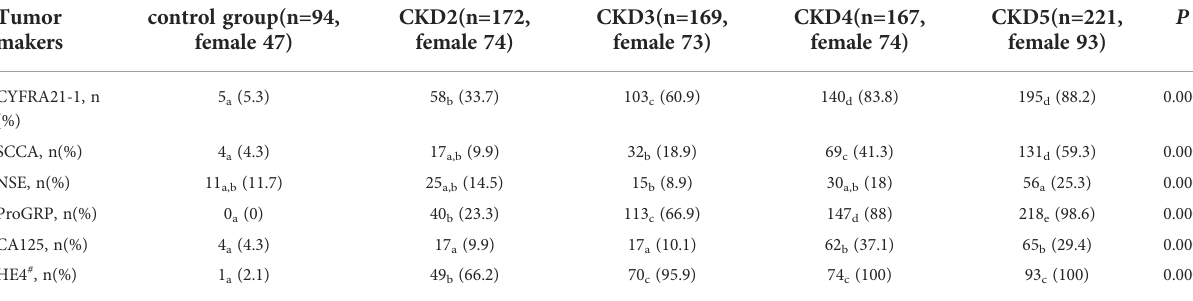
TABLE 4 The false positive* rate analysis of tumor markers in patients with different stages of CKD. Tumor makers